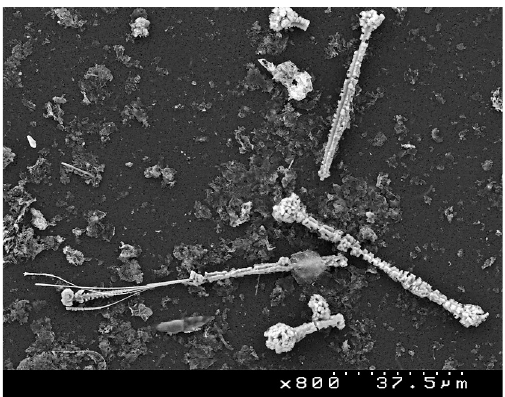
Fig. 1 Scanning electron microscope of asbestos